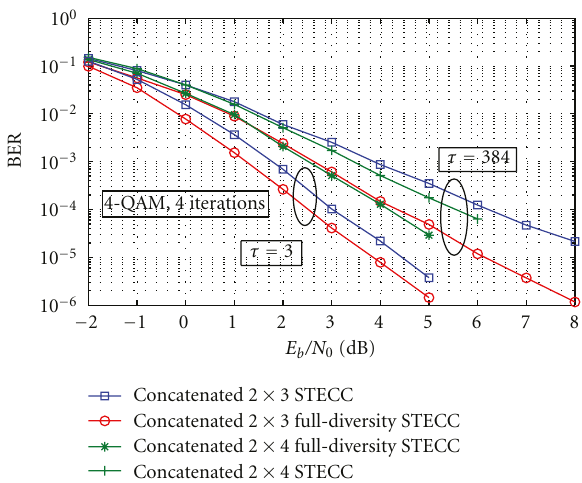
sity STECC and the concatenated STECC. 1530 information bits. n CC (7,5) r = 2. oct